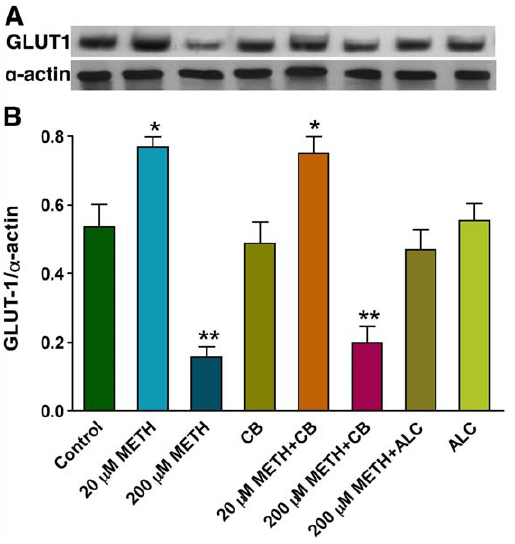
Figure 8. Western blot analysis of GLUT1 in METH treated human astrocytes: A: Effects of METH on 45 kDa GLUT1 protein levels in human astrocytes. The effects of cytochalasin B and ALC on GLUT1 expression also showed in the band pattern. B. Results are expressed as ratio of GLUT1 to that of a -actin bands, and presented as the mean values ( 6 SEM; n=5). (Statistically significant, *p , 0.05 **p , 0.01 compared with controls).